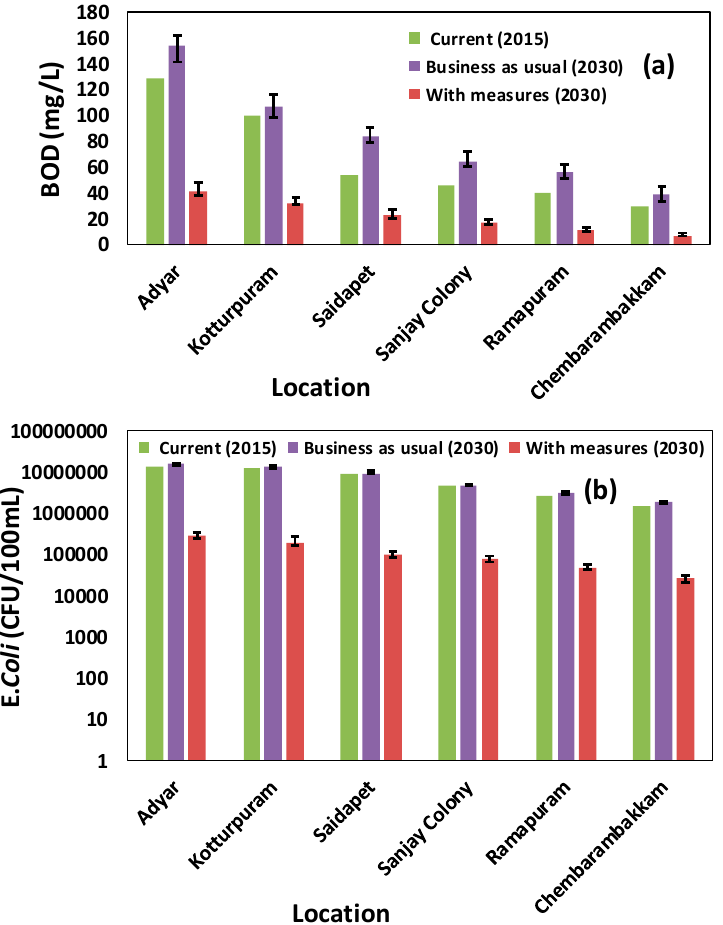
Figure 9. Simulated water quality parameters ( a ) BOD and ( b ) Eschericia coli for 2015, BAU (2030) and with measures (2030) scenarios.